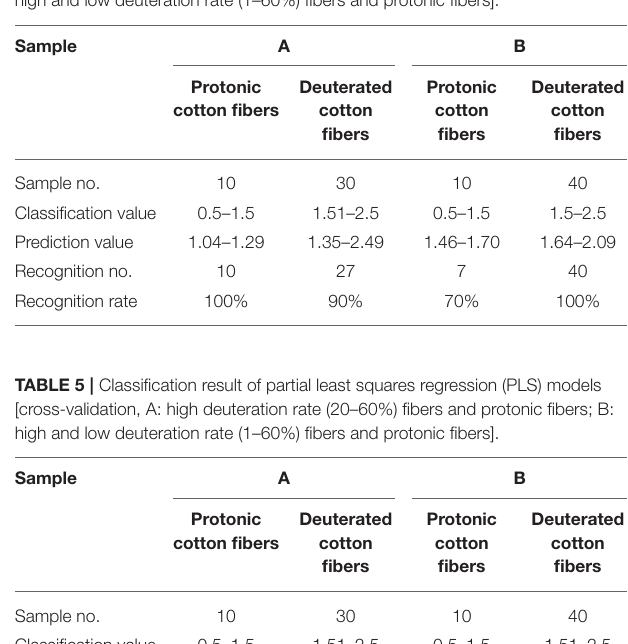
TABLE 4 | Classification result of principal component regression (PCR) models [cross-validation, A: high deuteration rate (20–60%) fibers and protonic fibers; B: high and low deuteration rate (1–60%) fibers and protonic fibers].